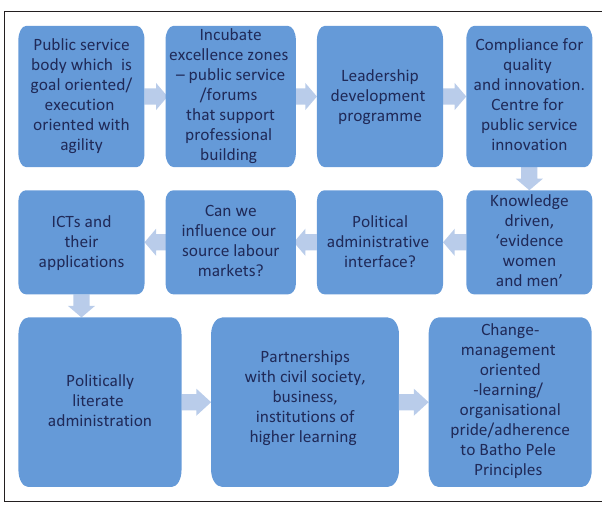
FIGURE 3: Organizational workflow